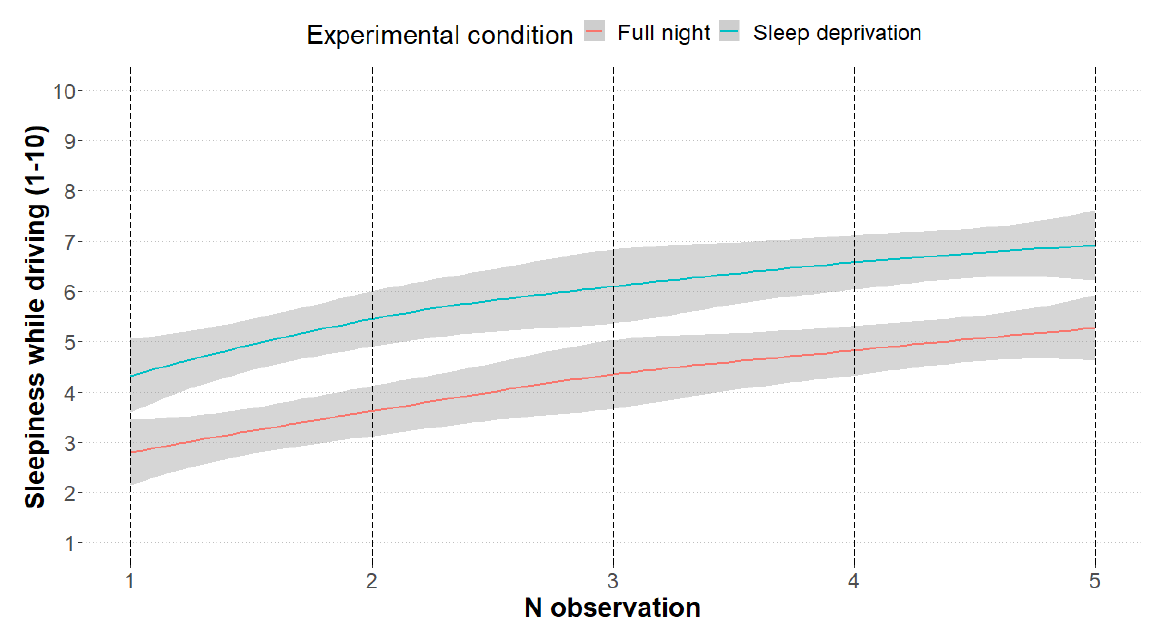
Figure 3. The smooth curves represent the subjective sleepiness scores among the 5 detection events (minutes: 9, 18, 27, 35, 45), divided by experimental condition (red: no sleep and 8 h sleep; blue: sleep deprivation and 5 h sleep).